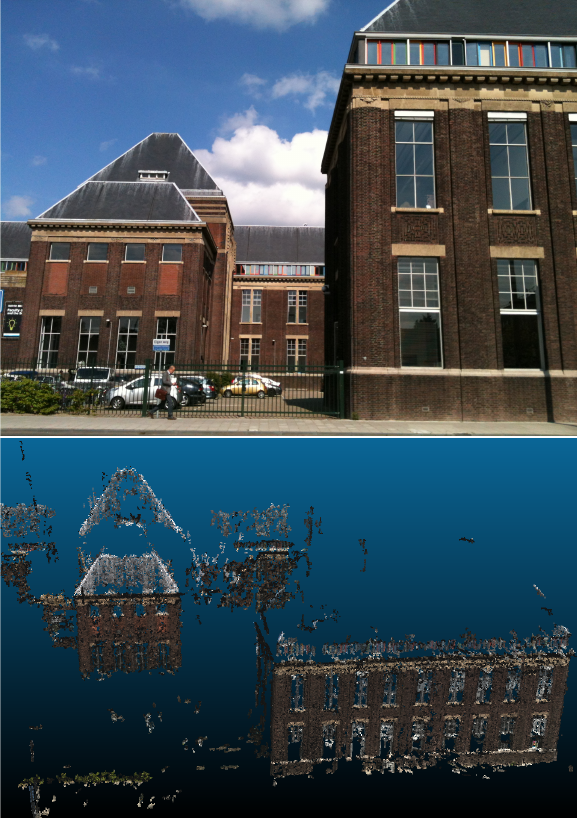
Figure 5: Top; A sample iPhone video frame from the building of interest. Bottom; Automacatically generated point cloud.